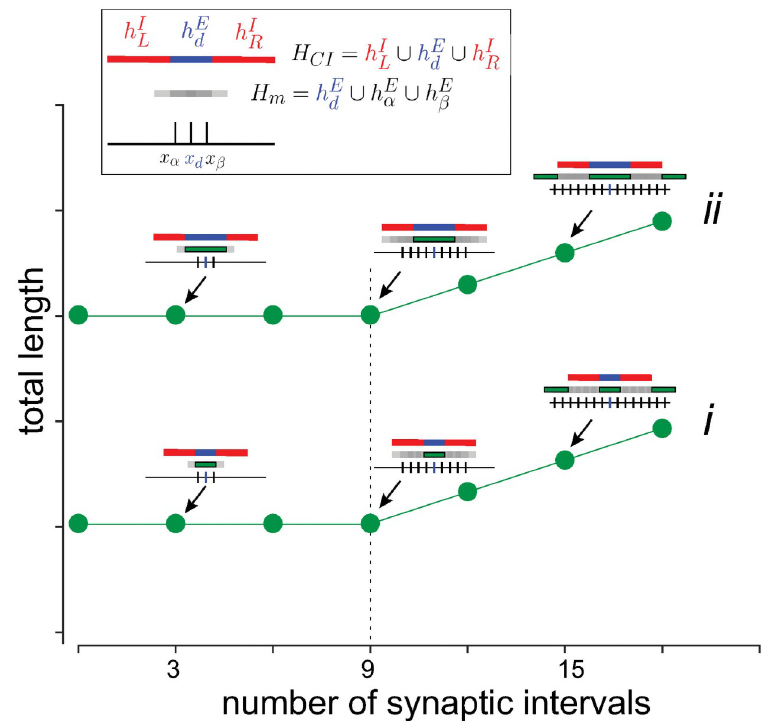
Fig 9. Algebra of loudness summation. Predicted interval lengths resulting from the interaction of multi-tone stimulus delivered simultaneously. Boxed inset , overlapping synaptic intervals ( H frequency components. Tic marks show location of interval centers ( x α , x d , x β ) along tonotopic axis. The dominant tone (blue) also generates two inhibitory side bands (red). Plot shows resultant length ( j h the operations (see text) as the number of intervals in H m is increased (abscissa). Green bars in insets show portion of H m that was not cancelled by inhibition. Dotted vertical line marks deviation of curves from a constant value. Compare with Figs 9 of [37].